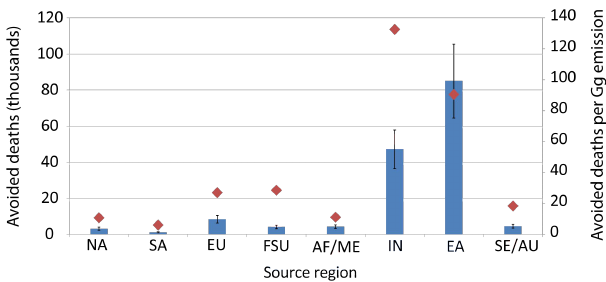
Fig. 7. Global annual avoided premature cardiopulmonary and lung cancer deaths (thousands; blue bars) and avoided premature deaths per Gg BC emissions reduced (red diamonds), for halving anthro- pogenic BC emissions in each source region relative to the base case. Confidence intervals (95%) reflect uncertainty in the CRF